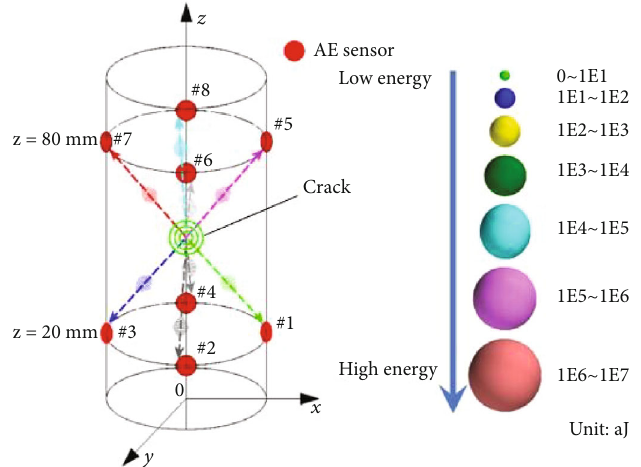
Figure 11: Layout of AE monitoring system and categorization of AE